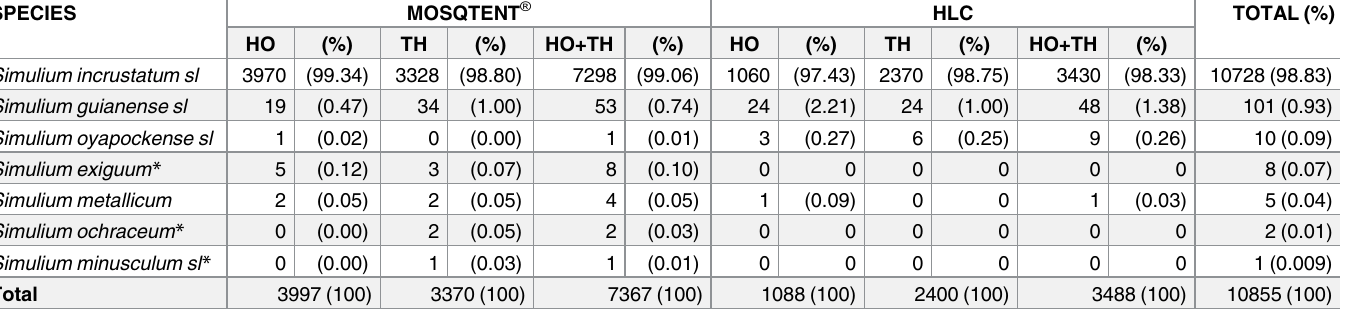
Table 1. Simulium species captured during the five days of the experiment with MosqTent ® trap and HLC method, at Homoxi and Thirei sites, Roraima/Brazil, in May 2016.